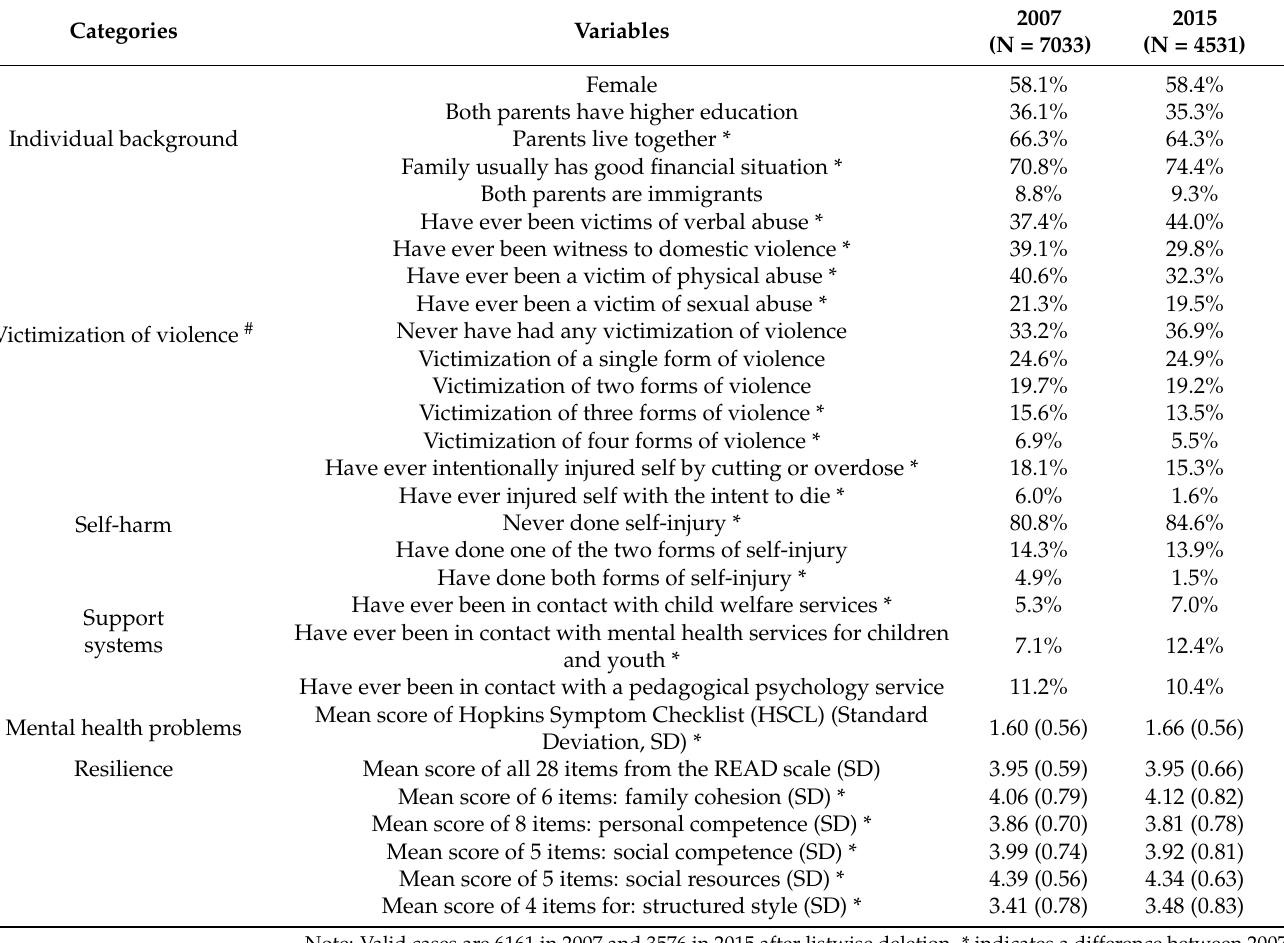
Table 1. Descriptions of variables used in this